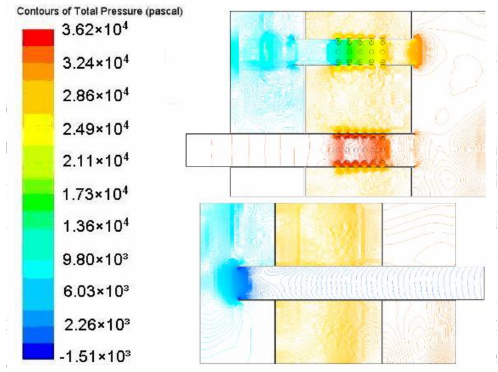
Figure 12. Contour of total pressure in the cross section of the silencer.